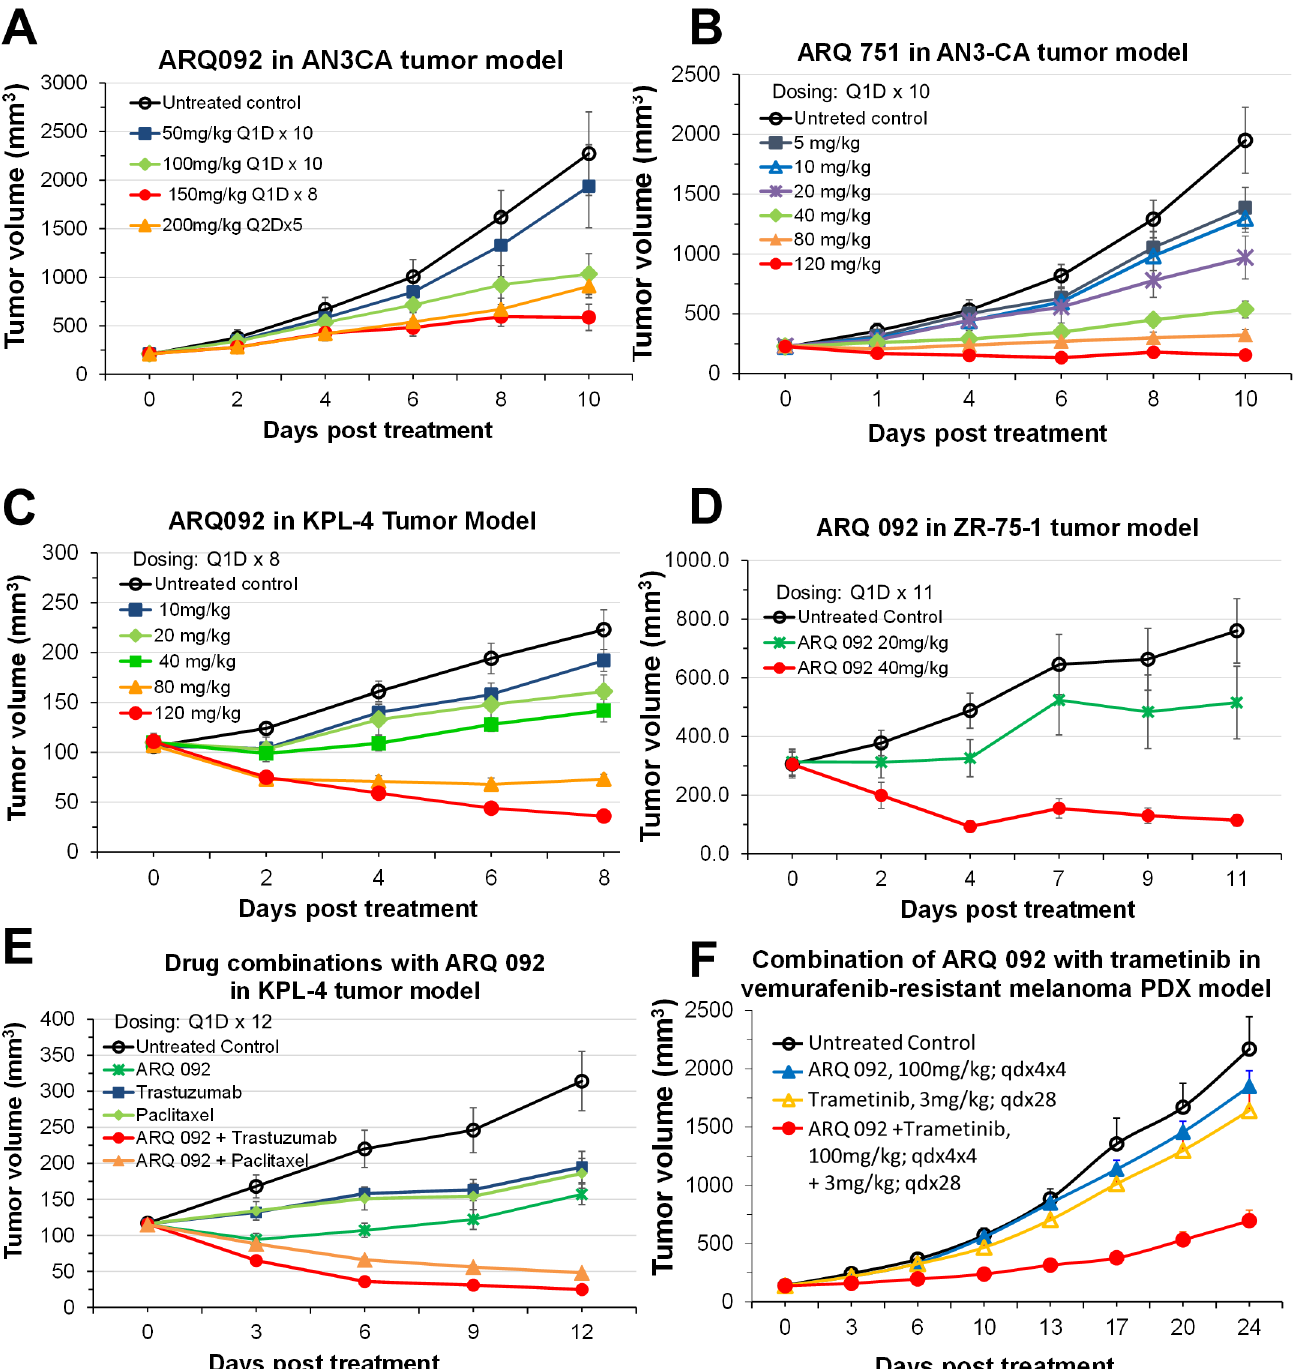
Fig 8. Antitumor activity in various mouse xenograft models after treatment with ARQ 092 or ARQ 751. (A) AN3CA xenograft model treated with ARQ 092, (B) AN3CA xenograft model treated with ARQ 751, (C) KPL-4 xenograft model treated with ARQ 092, (D) ZR-75-1 xenograft model treated with ARQ 092, (E) KPL-4 xenograft model treated with ARQ 092 as a single agent or combined with trastuzumab or paclitaxel, (F) A PDX melanoma model (ST052C) that contained Braf V600E and PIK3CA (H1047R) mutations treated with ARQ 092 as a single agent or combined with trametinib.